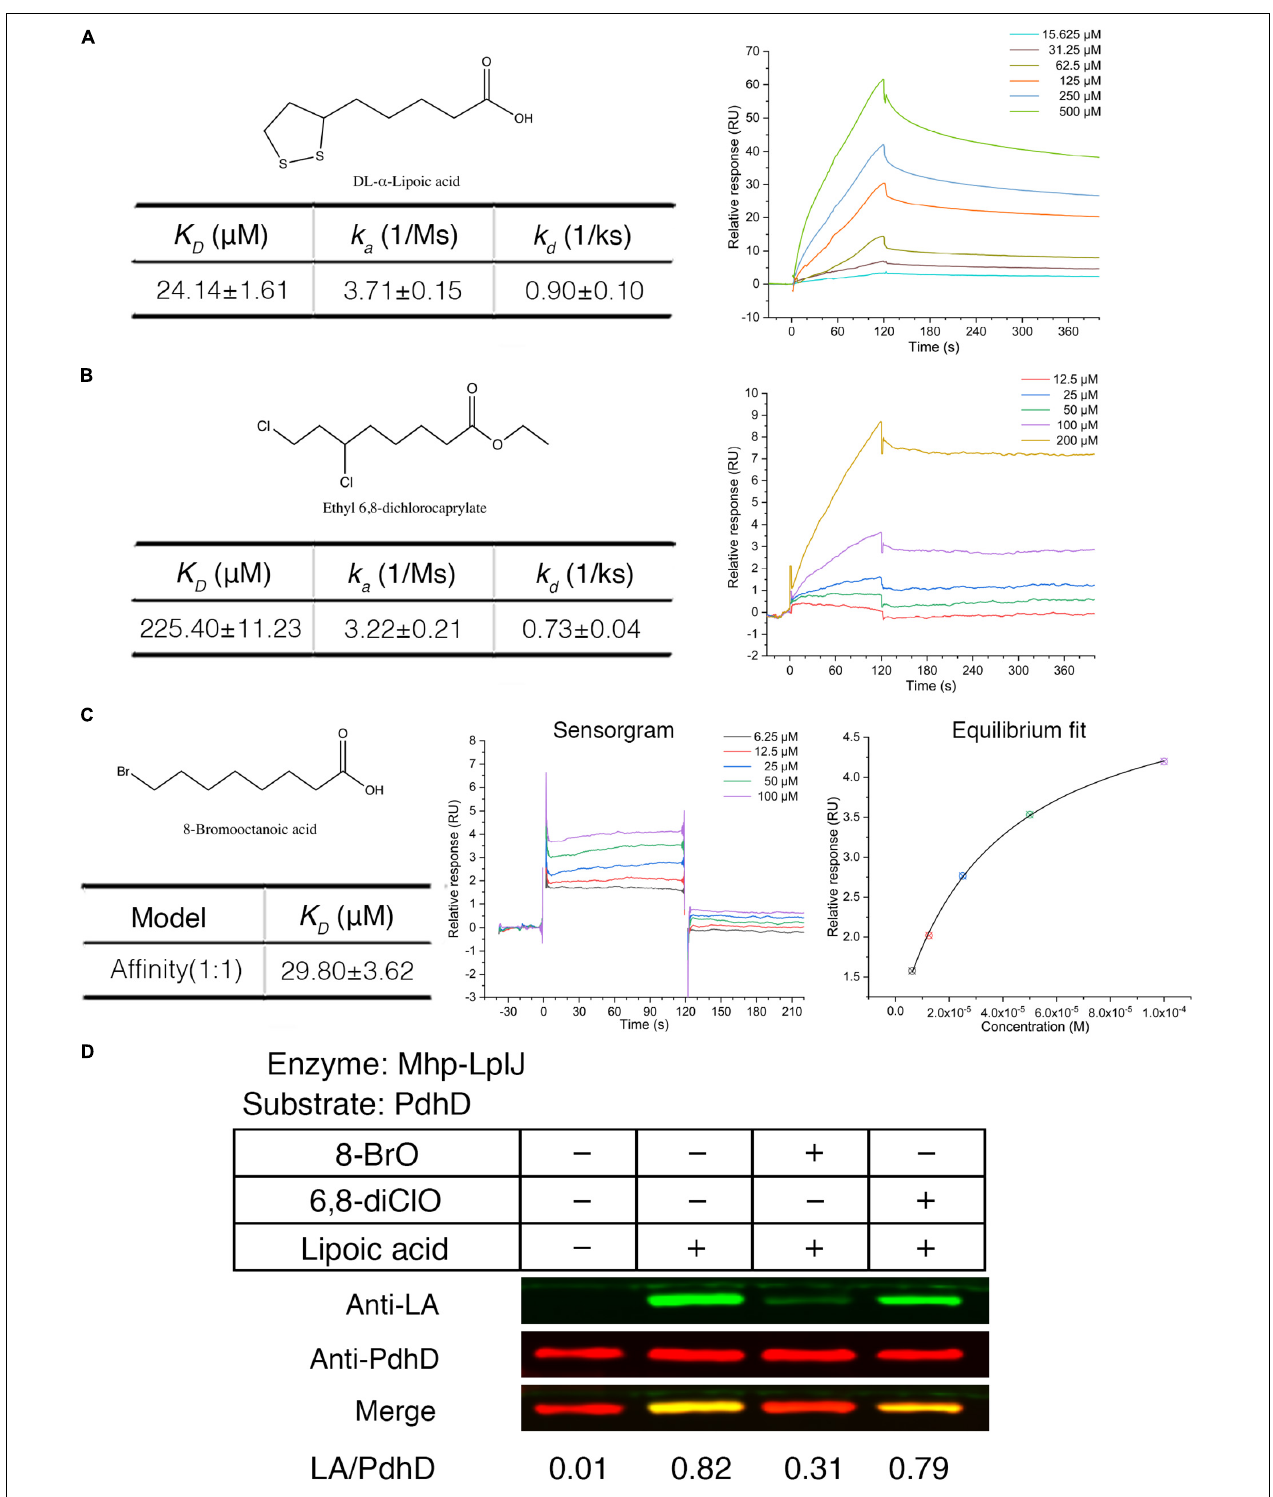
FIGURE 7 | Lipoic acid analogs 8-BrO and 6,8-diClO can affect the lipoylation of PdhD catalyzed by Mhp-LplJ in vitro . Real-time interactions of lipoic acid and analogs binding to Mhp-LplJ were assessed by SPR. (A) Structure of lipoic acid and sensorgram for lipoic acid binding to Mhp-LplJ. (B) Structure of 6,8-diClO and sensorgram for 6,8-diClO binding to Mhp-LplJ. (C) Structure of 8-BrO, sensorgram and equilibrium fit for 8-BrO binding to Mhp-LplJ. (D) Lipoic acid analogs disturbed the lipoylation of PdhD catalyzed by Mhp-LplJ. In the lipoate ligation assay, lipoic acid and its analogs (1 mM) were added as indicated. The results were detected by western blot analysis using Anti-LA (green) and Anti-PdhD (red) after reaction.